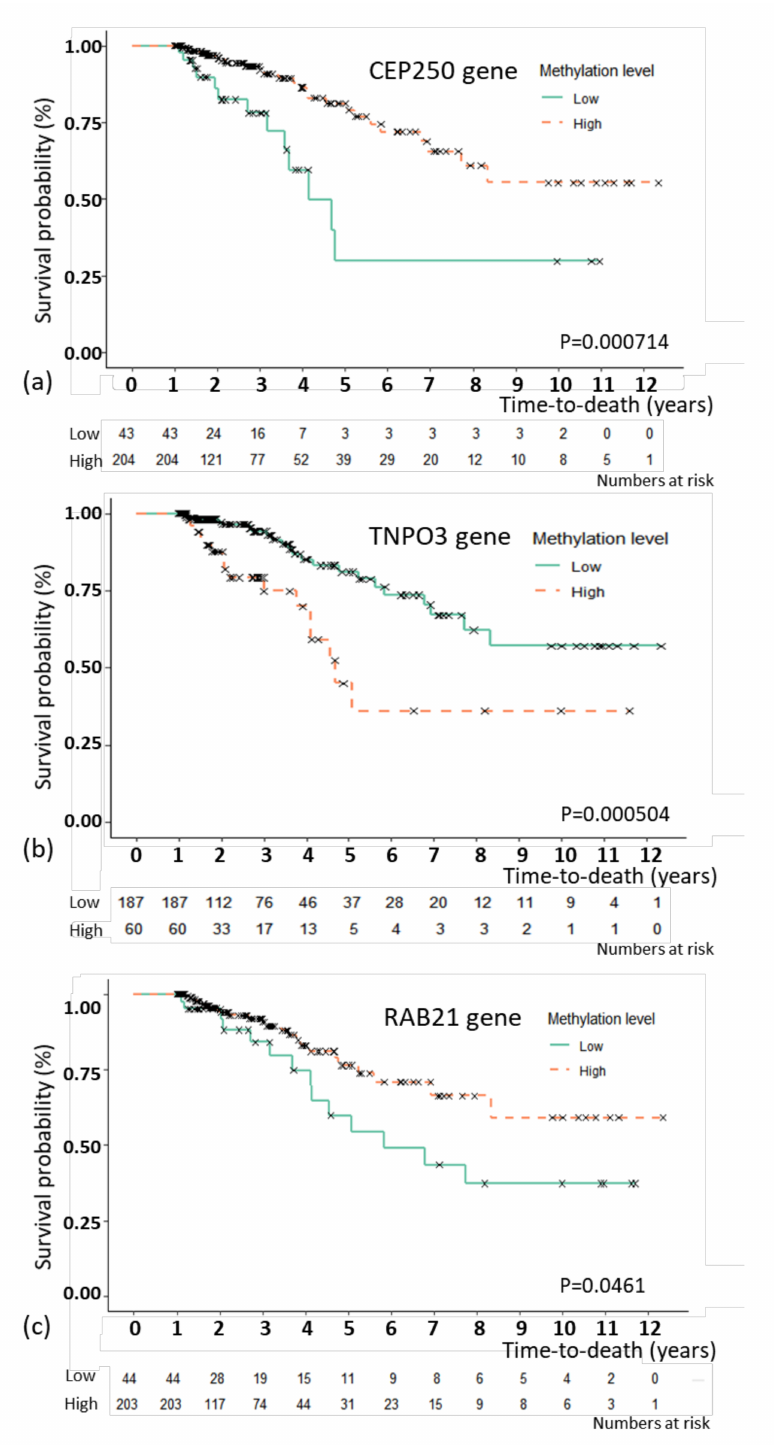
Figure 2. Kaplan–Meier plot of overall survival with genes that were significant in the multivariate Cox proportional hazard regression analysis. Kaplan–Meier plot of overall survival with the CEP250 ( a ), TNPO3 ( b ), and RAB21 ( c ) genes. The patients were divided by the optimal cutoffs for each feature based on MaxStat ( − 0.923 for CEP250; 0.5 for TNPO3, and − 0.367 for